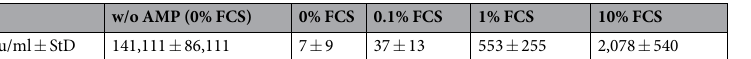
Table 1. Effect of FCS on AMP2 (67 µ g/ml) activity. Shown are the results of bacterial growth in cfu/ ml ± standard deviation (n = 3). Data are shown as means with standard deviation. Regression analysis: R 2 = 0.862 with p = 0.000012.